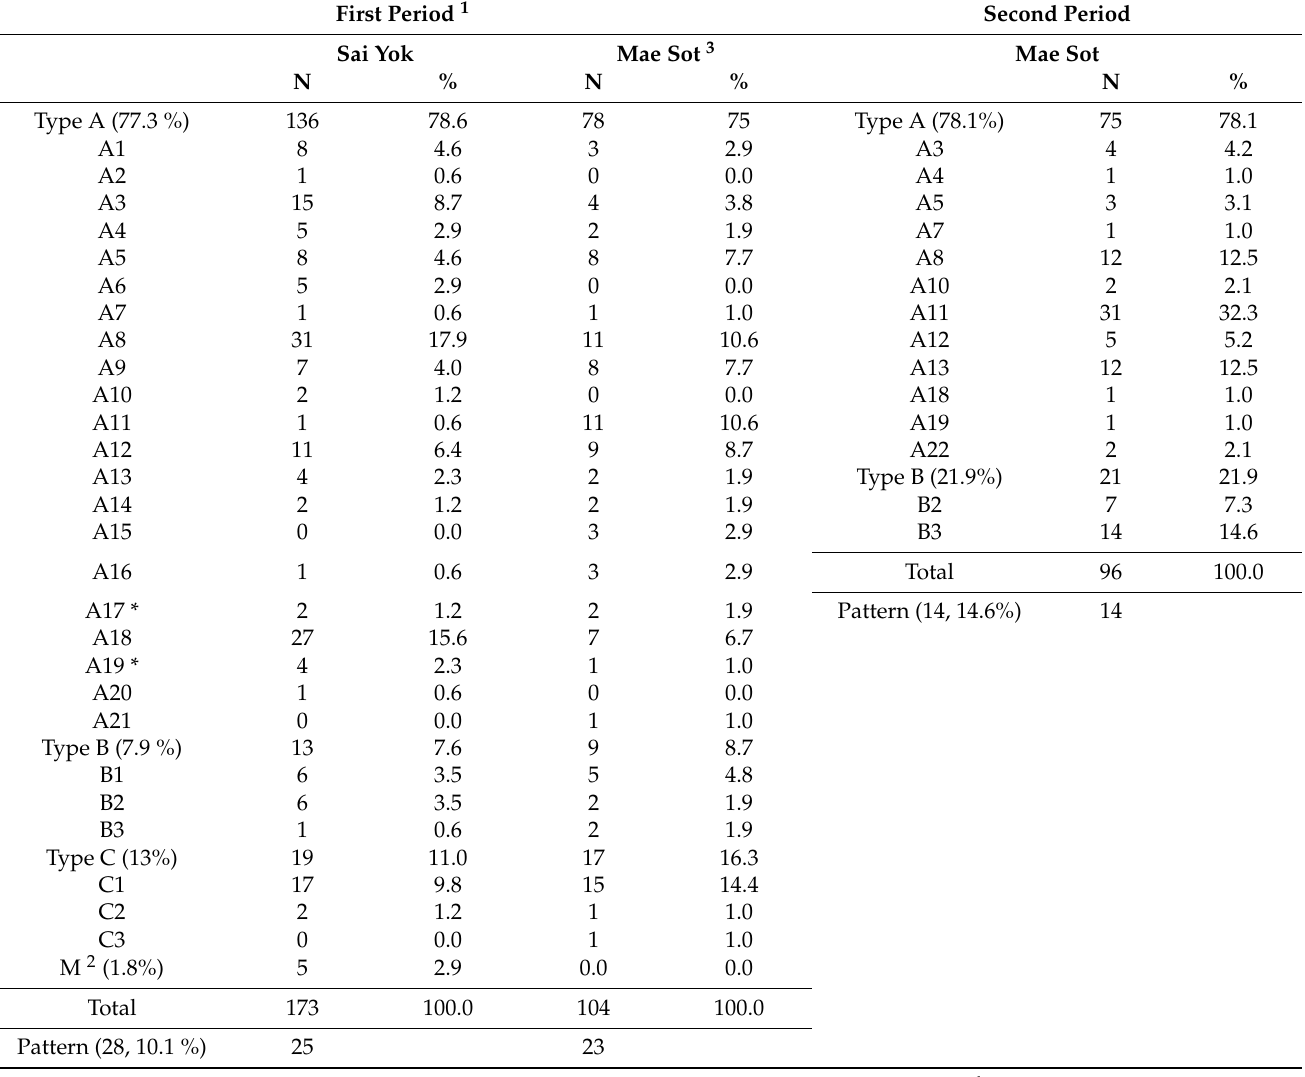
Table 2. The proportion of PvMSP-3 α from the first (2006–2007) and second (2014–2016) periods. First Period